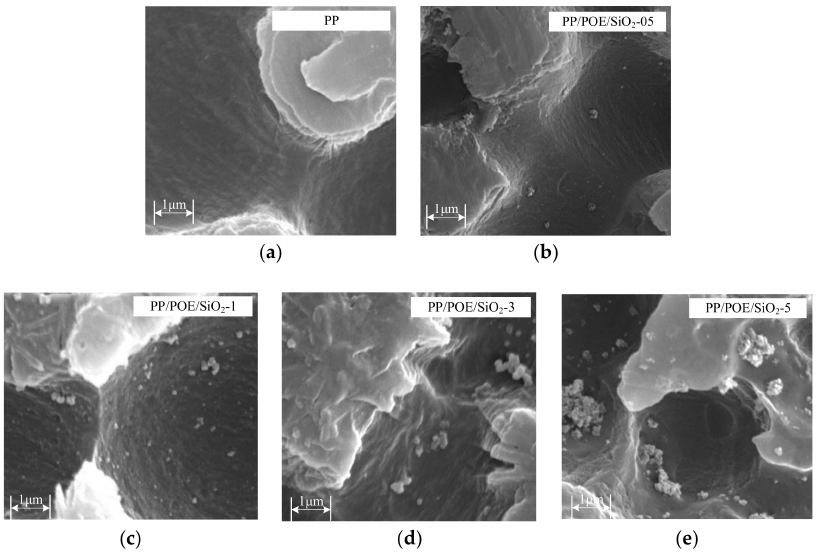
Figure 2. Dispersion of nano-SiO 2 particles in the nanocomposites. The high brightness and continuous regions were PP crystalline areas that were not attacked in the etching process, and the small spherical regions were nano-SiO 2 : ( a ) PP, ( b ) PP/POE/SiO 2 -05, ( c ) PP/POE/SiO 2 -1, ( d ) PP/POE/SiO 2 -3, ( e ) PP/POE/SiO 2